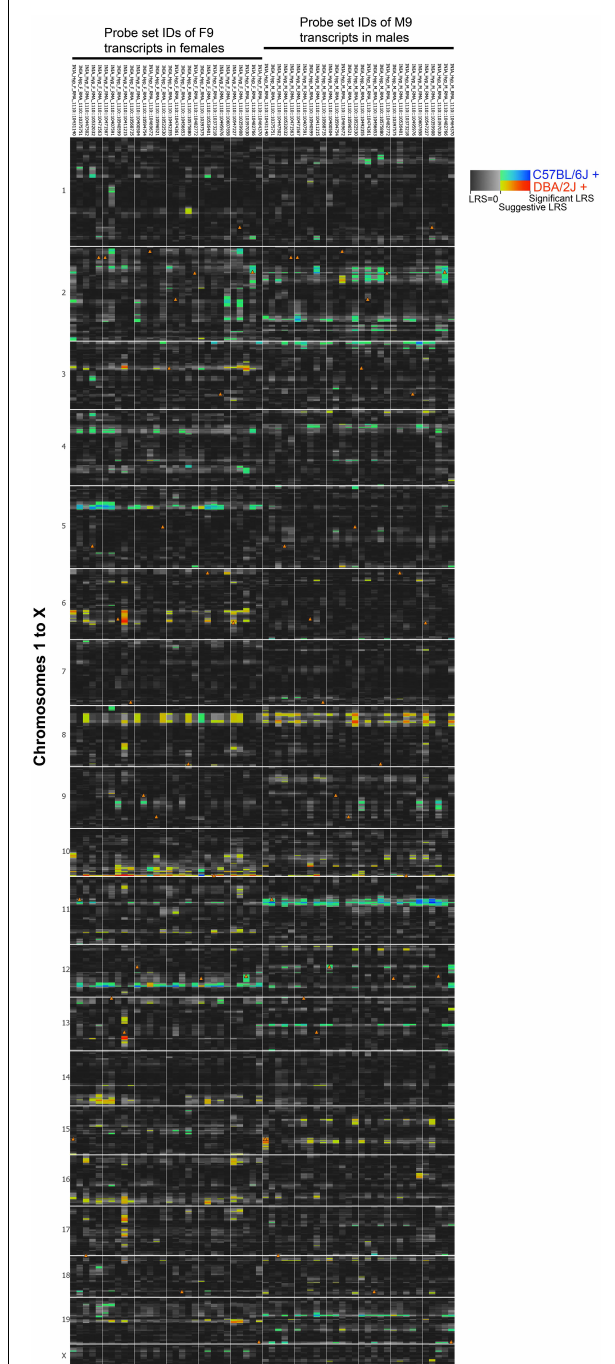
FIGUREA2 | Sex-specific eQTLs for coexpressed transcripts. Thirty transcripts in modules F9 and M9 with high network connectivities were used for eQTL mapping.To provide a side-by-side comparison of eQTLs in females (left) and males (right), LRS are displayed as a heat map. Each column represents a transcript and rows represent chromosome 1 to x .The color intensity encodes the linkage strength and the parental allele effect. Locations of cognate genes are shown by